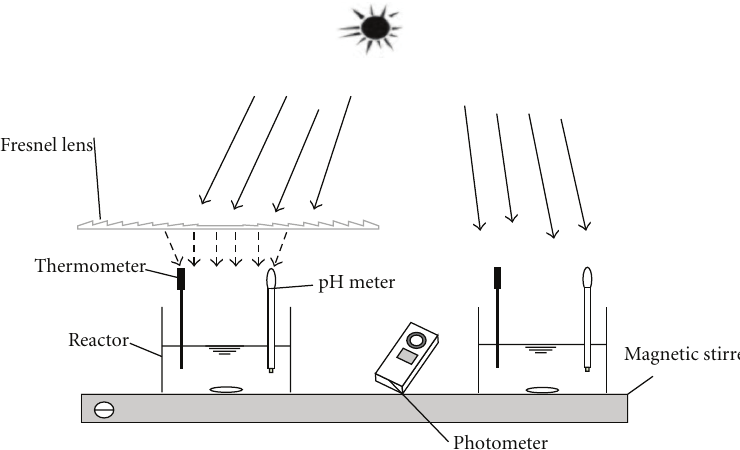
Figure 1: Schematic diagram of the solar photoreactor with and without Fresnel